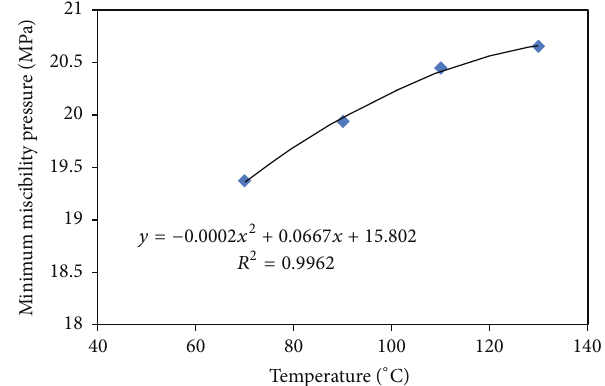
Figure 3: Variation of oil sample miscibility pressure with temper-